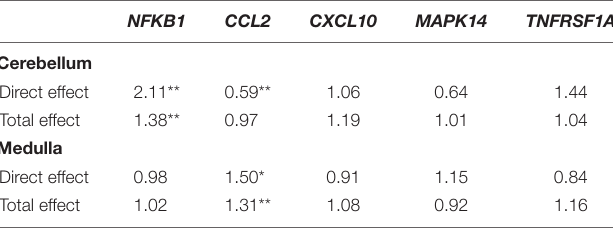
TABLE 6 | Direct and indirect effect (OR) of the 5 genes in the cerebellum and medulla brain